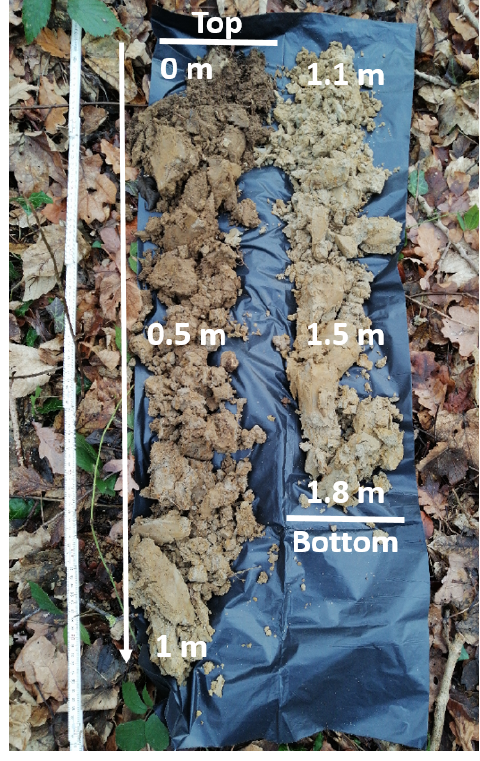
Figure 6. Output from auger drilling arranged according to approximate depth in the